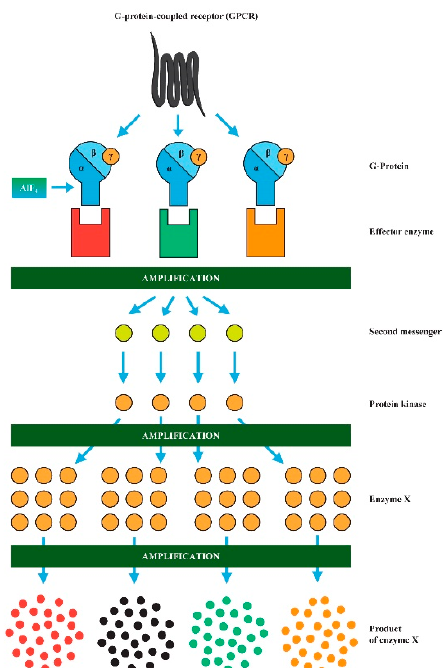
Figure 2. Amplification of signaling pathways by AlF 4 − . Its message is greatly amplified during the conversion into the functional response of a cell. Effector enzymes are adenylyl cyclase or phospholipase C. The second messenger molecule could be cAMP, inositol 1,4,5- trisphosphate, and diacylglycerol.